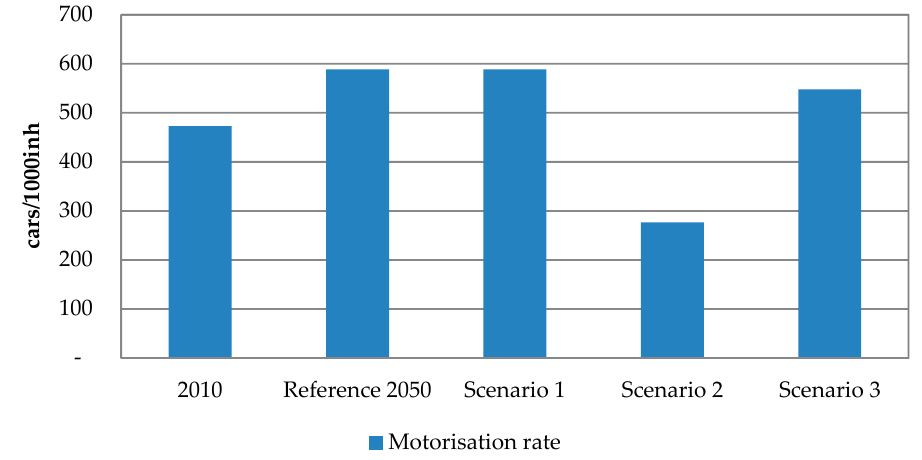
Figure 3. Motorisation rate in scenarios. Source: Fiorello et al. [8] for EU-27 population, number of vehicles from scenarios.